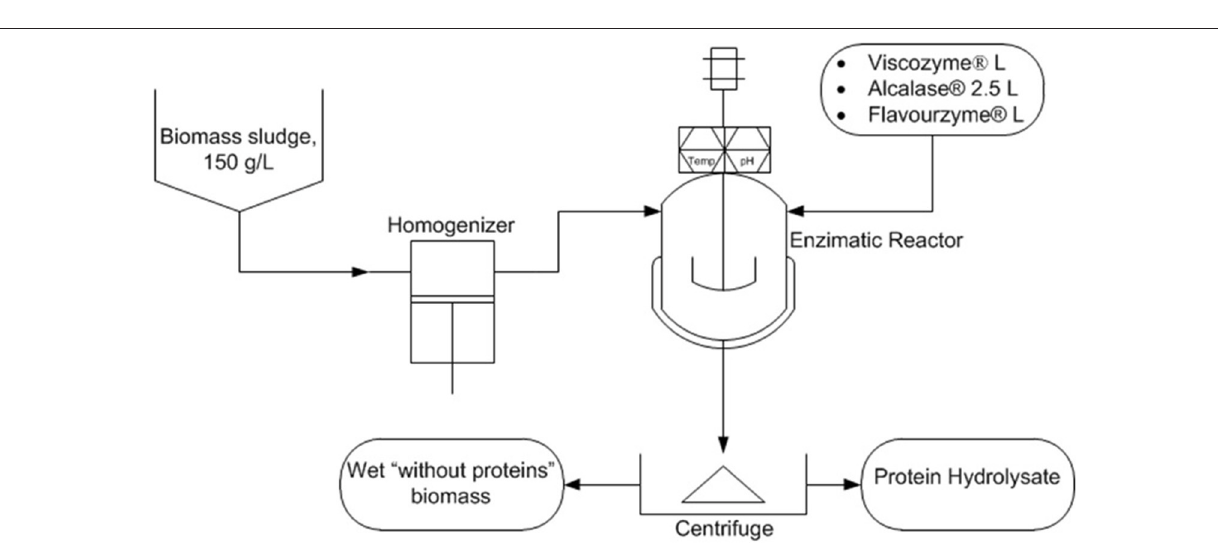
Frontiers in Sustainable Food Systems |